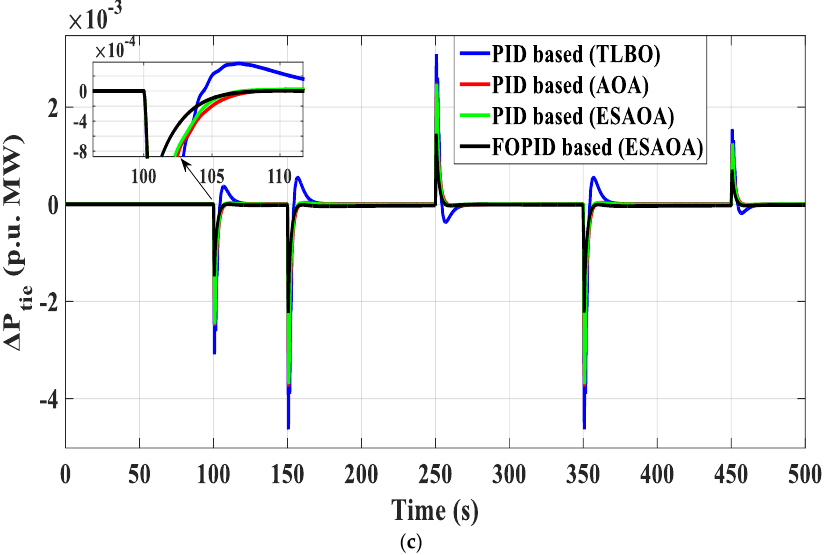
Figure 17. Dynamic system response of scenario A with series SLP at the first area ( a ) ∆𝑓 1 , ( b ) ∆𝑓 2 , and ( c ) ∆𝑝 𝑡𝑖𝑒 .